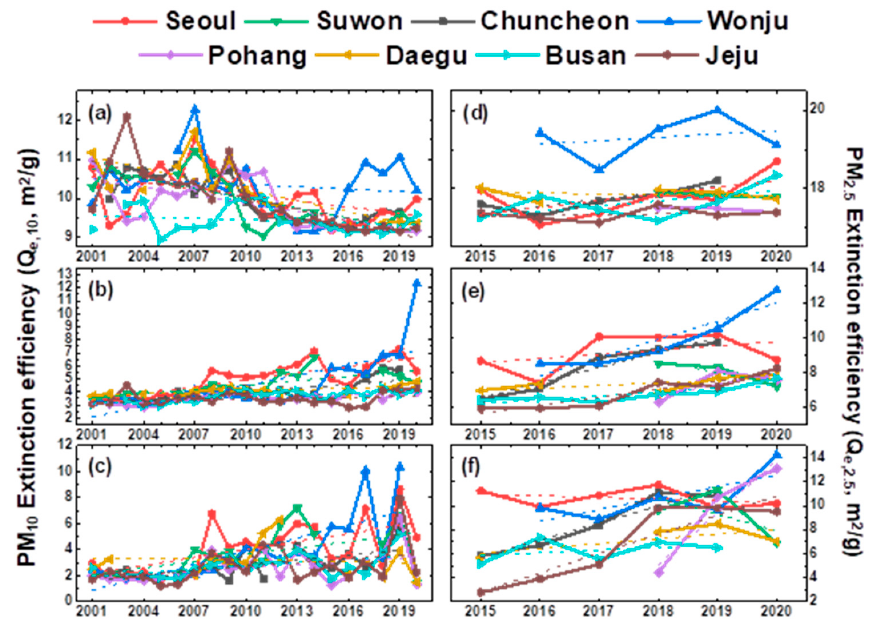
Figure 7. Change in Q e for each concentration category of PM 10 and PM 2.5 in each city. PM 10 : ( a ) 19–